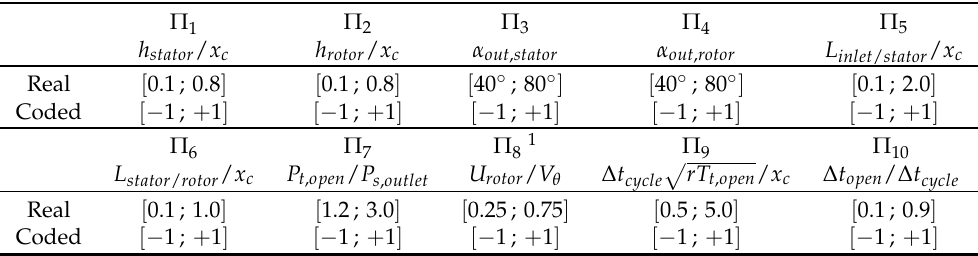
Table 2. Factors and experimental domain of the screening